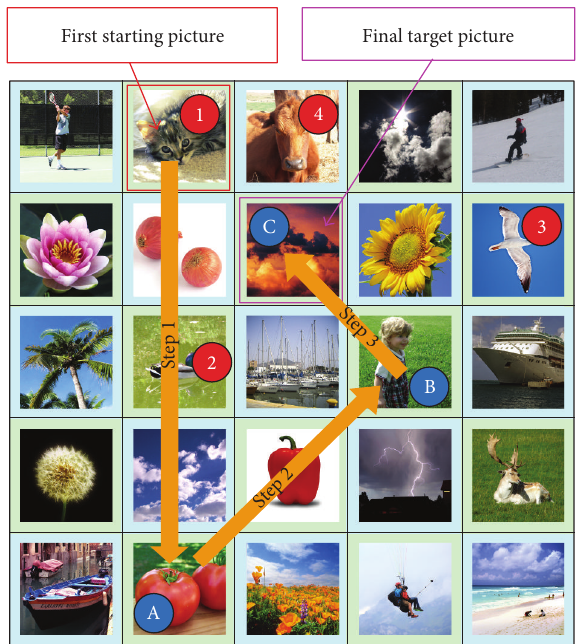
Figure 10: A special scenario: starting picture is the same with cued picture.